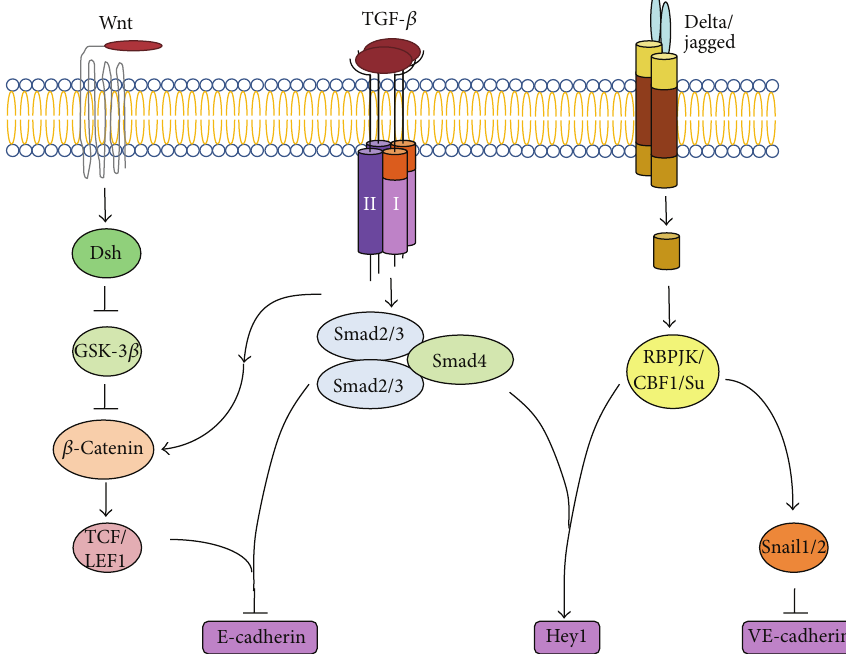
Figure 4: Signaling crosstalk between the TGF- 𝛽 -activated pathway and other pathways during EMT (according to Xu et al. [94]).